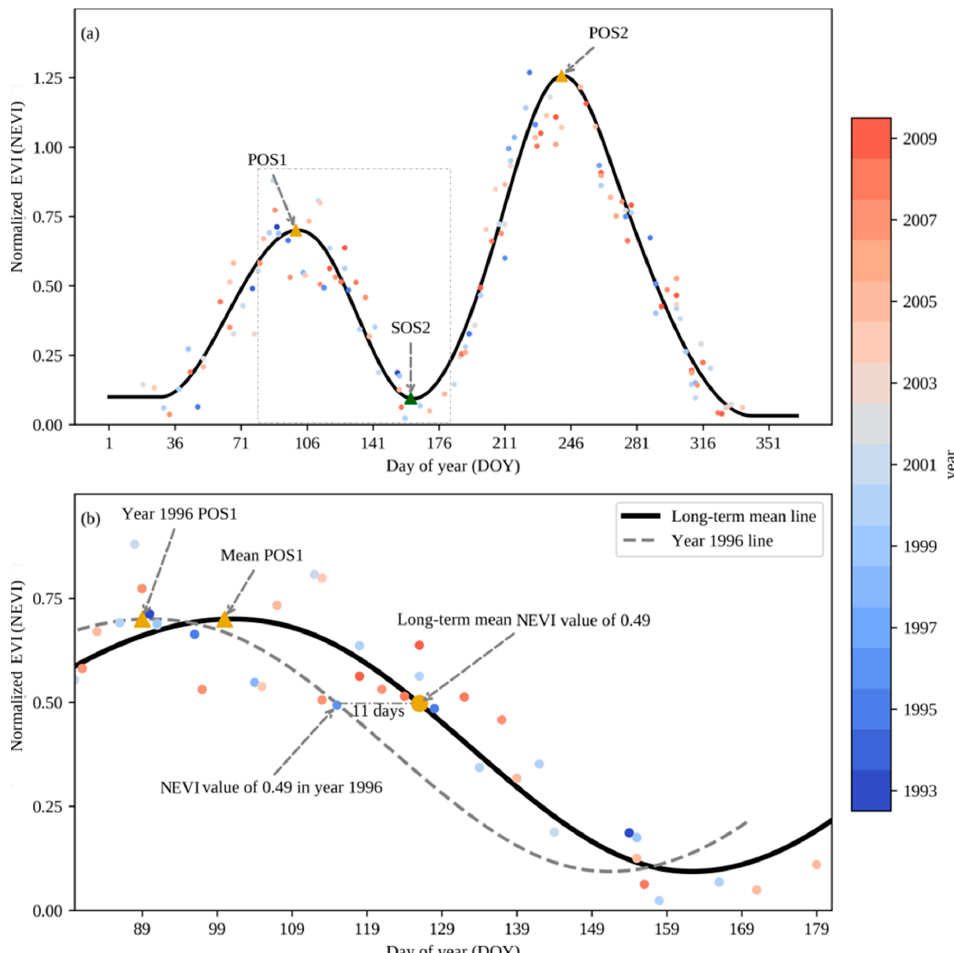
Figure 2. Schematic demonstration of extracting annual phenological metrics based on multi-year Landsat images. ( a ) Solid line indicates the multi-year mean fitted line using cubic spline smoothing method. POS1 represents the peak of season of the first cropping cycle, SOS2 indicates the start of season of the second cropping cycles, and POS2 is the peak of season of the second cropping cycle. Colored points stand for normalized enhanced vegetation index (NEVI) in different years. POS1 and POS2 are defined as the first and second peak of the two cropping cycles, respectively. SOS2 is defined as the trough between the two neighboring peaks. Dashed box in panel (a) shows the boundary of the zoom-in plot of panel (b); ( b ) Solid line is a zoom-in version of the dashed box in panel (a). Dashed line is the fitted phenological curve in year 1996 by shifting multi-year fitted line to the left by 11 days. Eleven days were calculated as the deviation between the acquisition DOY in year 1996 and the DOY of fitted NEVI time series which corresponds to the same NEVI value in year 1996. We did not